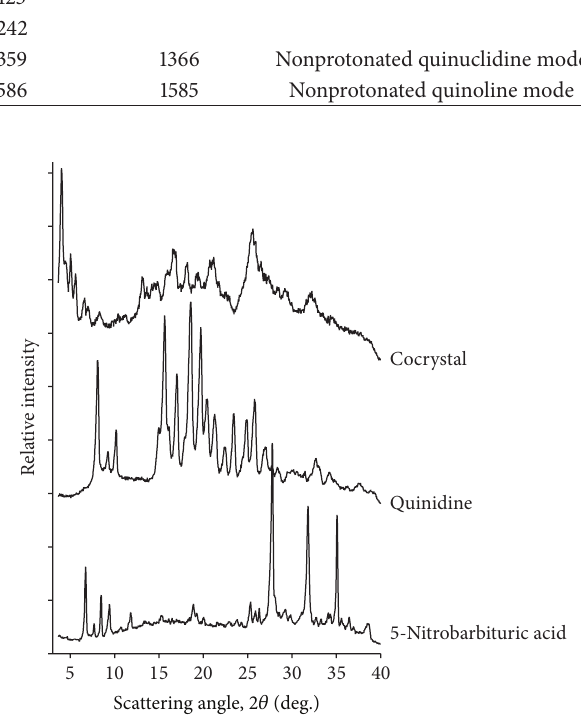
Figure 11: Raman spectra within the fingerprint region of 5- nitrobarbituric acid, quinine, and the 1:1 nitrobarbituric-quinine